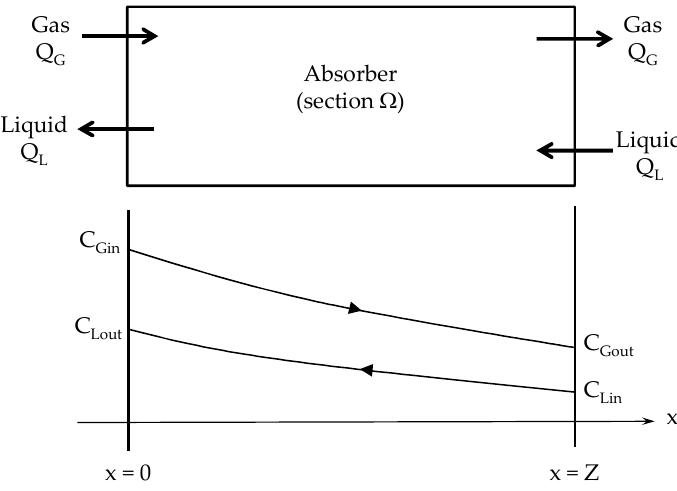
Figure 2. Concentration profile throughout the length of the gas–liquid countercurrent absorber.